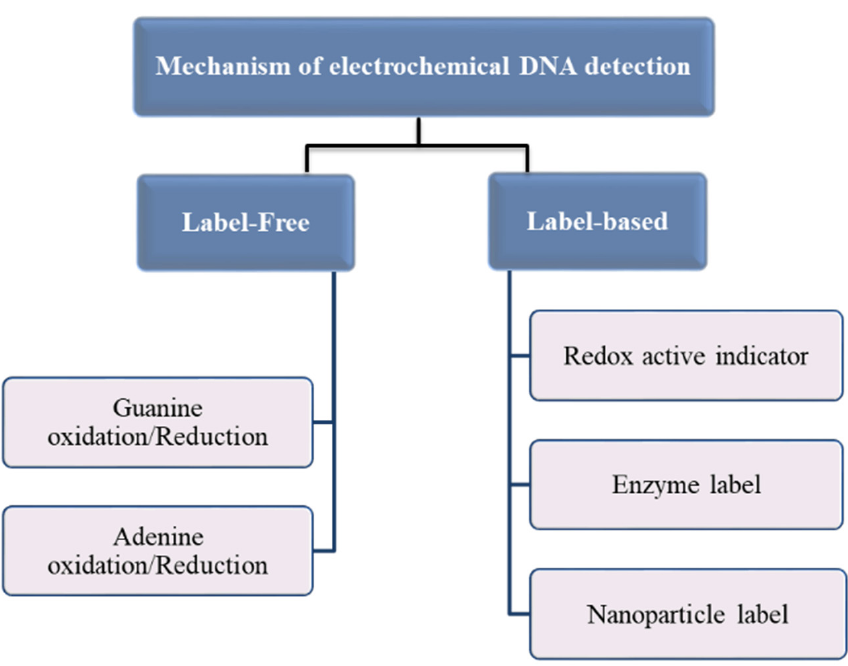
Figure 3. Mechanism of electrochemical DNA detection.